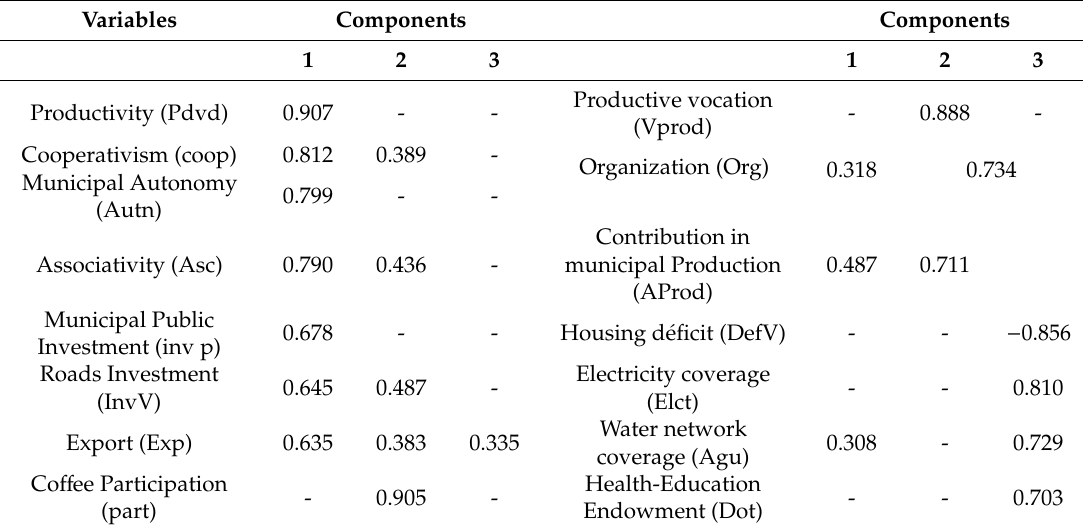
Table 2. Factorial loads by method of extraction of main